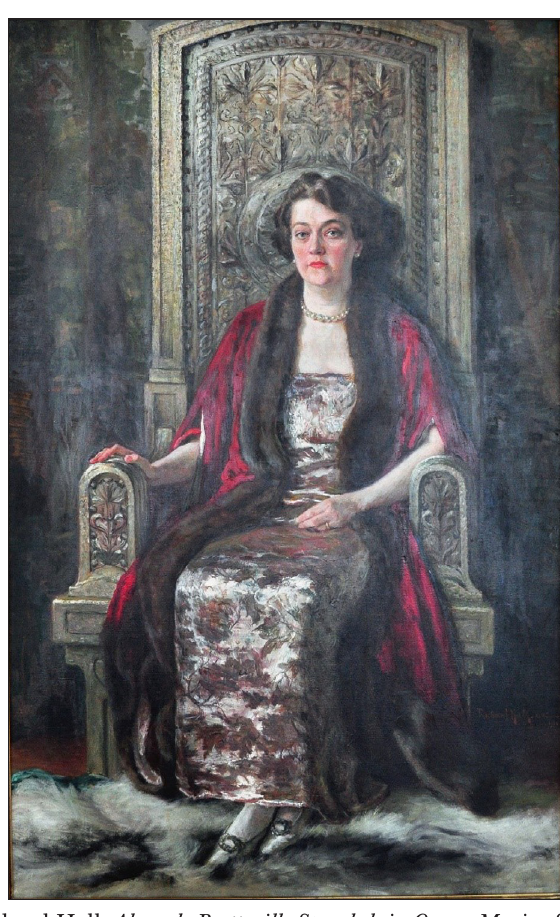
Fig. 10 : Richard Hall, Alma de Bretteville Spreckels in Queen Marie of Roumania’s Audience Chair , 1924, oil on canvas, Maryhill Museum. Wikimedia